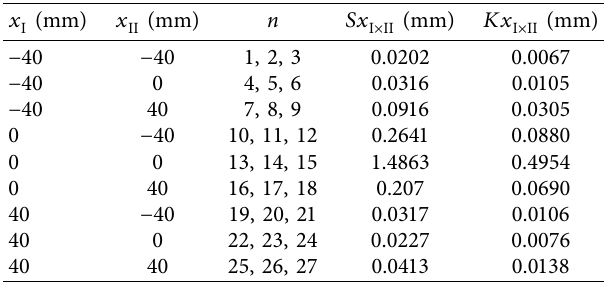
Figure 7: Relationship between supports’ positions and vibration deformation. Table 7: Effects of interaction support I × II.